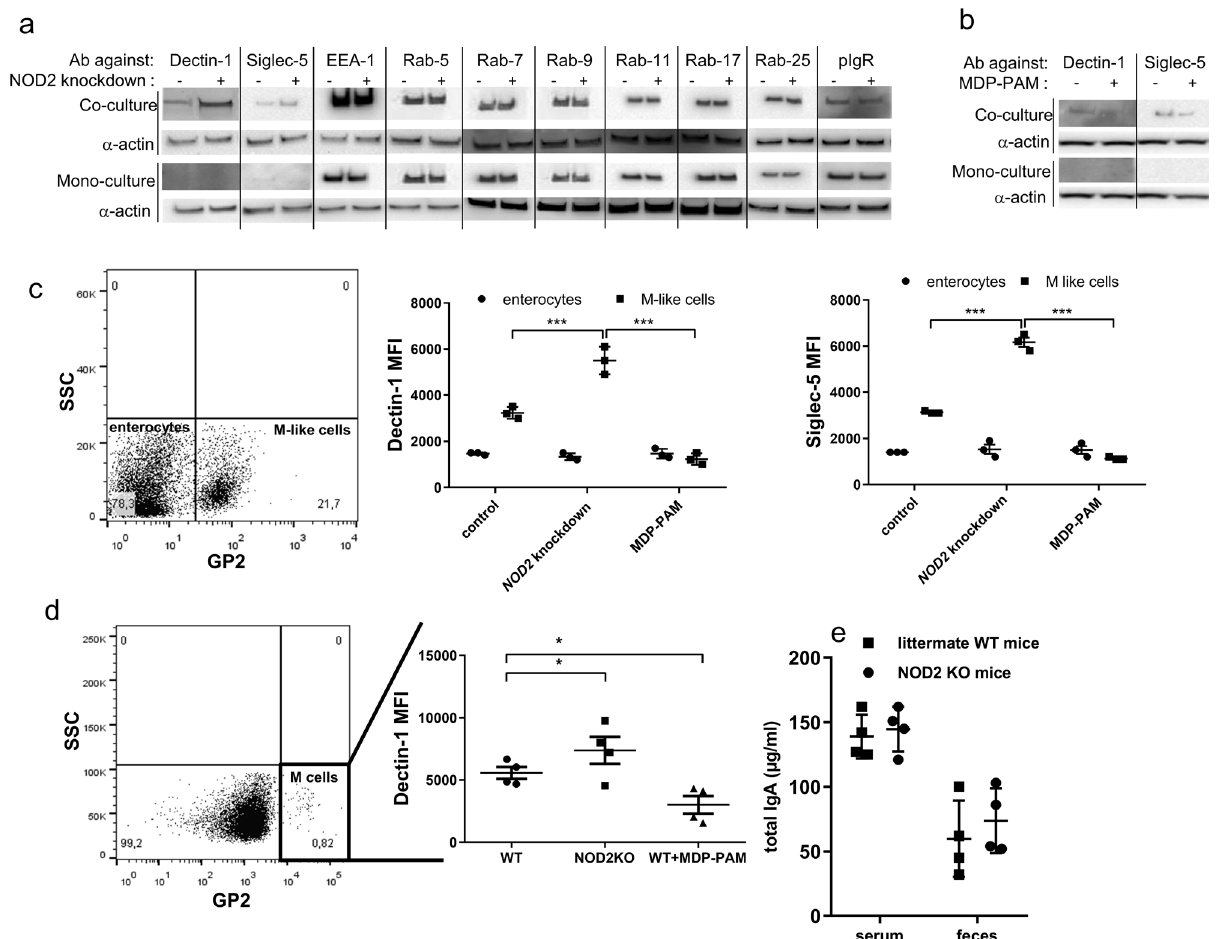
Fig. 5 NOD2 modulates the expression of Dectin-1 and Siglec-5 receptors. Western blot showing the expression of proteins in an in vitro model containing (co-culture) or not (mono-culture) M-like cells before “ − ” or after “ + ” NOD2 blocking of transcription with siRNA knockdown ( a ) or NOD2 stimulation with MDP-PAM treatment ( b ). These experiments were repeated twice with similar results. Flow cytometry was used to examine the role of NOD2 on Dectin-1 and Siglec-5 expression in M like cells in vitro ( c ) ( n = 3 independent experiments; Vertical bars show the mean value ± SEM; One-way ANOVA followed by Bonferroni post hoc test was used, p values: *** p < 0.005) and in vivo ( d ) ( n = 4 independent experiments; Vertical bars show the mean value ± SEM; A nonparametric Mann – Whitney U -test was used, p values: * p < 0.05). e Total IgA concentration was determined by ELISA in serum and faeces of NOD2KO mice and littermate WT mice. n = 4 biologically independent mice. One-way ANOVA followed by Bonferroni post hoc test was used. Vertical bars show the mean value ± SEM. kd knockdown, stim stimulation. Source data are provided as a Source Data fi